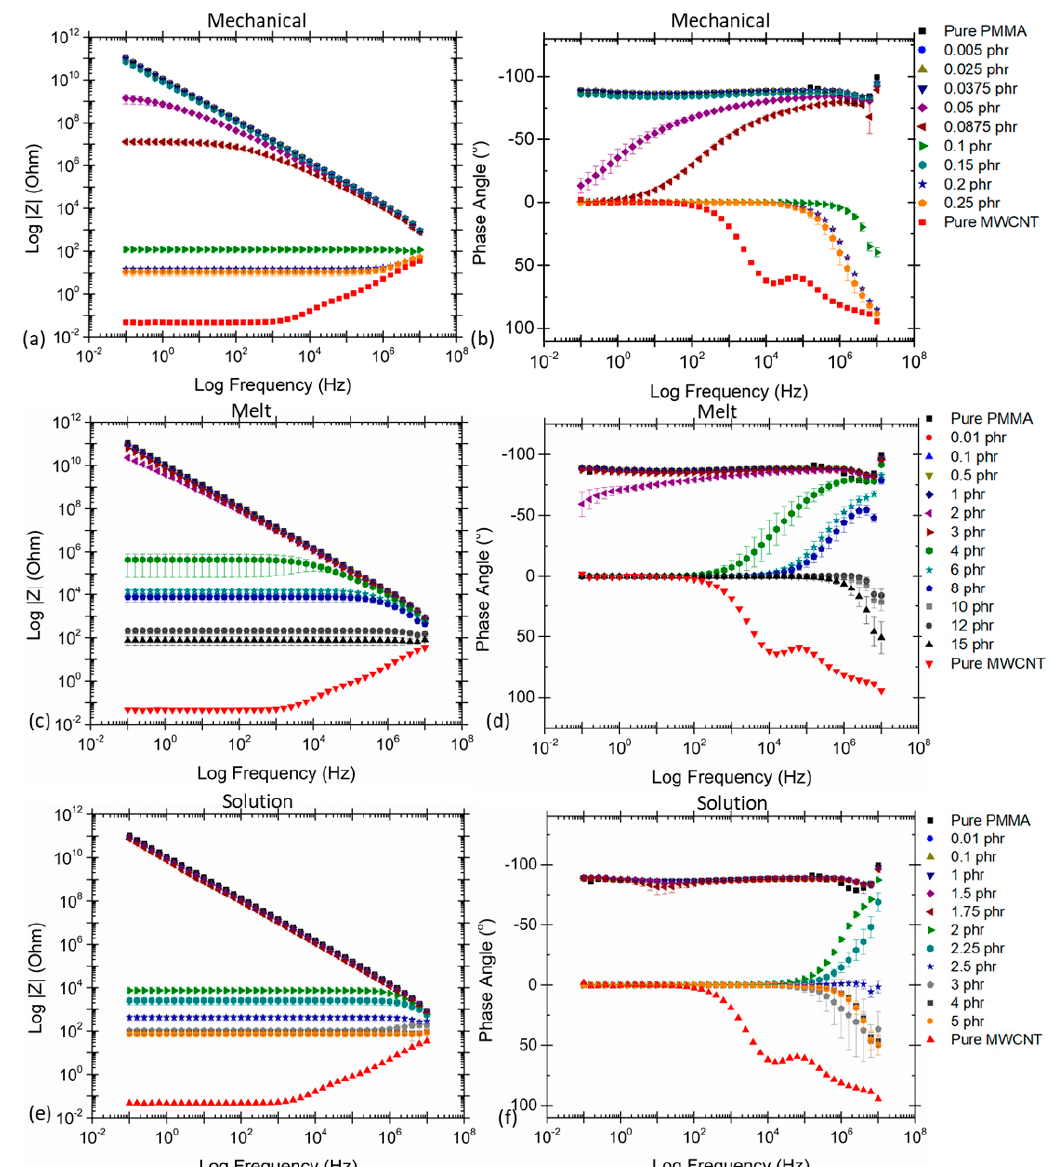
Figure 10. Impedance magnitude and phase angle vs. frequency for ( a , b ) mechanically, ( c , d ) melt, and ( e , f ) solution mixed CNT-PMMA composites [9].